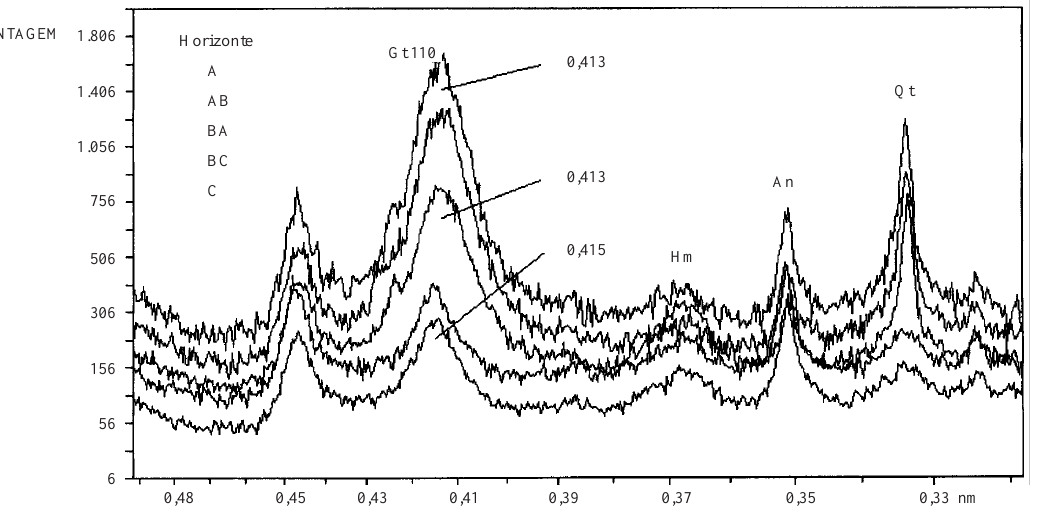
Figura 5. Difratogramas do pó de amostras com o concentrado dos óxidos de ferro, evidenciando a variação na posição dos reflexos da Gt dos horizontes A, AB e BA em relação aos horizontes BC e C do perfil 110 P1. (Gt = goethita; Hm = hematita; An = anatásio; Qt =